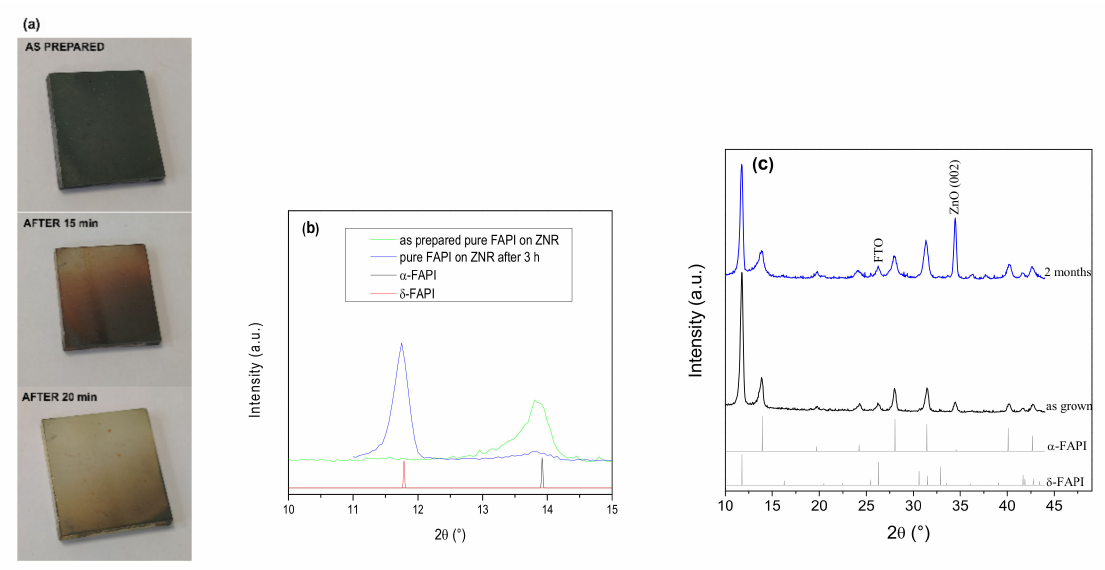
Figure 3. ( a ) Photographs of rapid degradation of pure FAPI film ( α -phase is black, δ -phase is yellow), ( b ) low-angle XRD patterns of the pure FAPI thin film on ZnR and ( c ) time-dependent XRD patterns of the FAPI thin-film infused with PVP on ZNR. A higher intensity of the ZnO (002) peak in the pattern of the aged sample is a consequence of the larger higher incidence angle of X-rays which resulted in a larger penetration